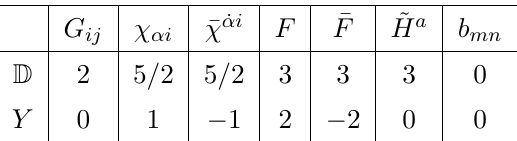
Table 2 . Summary of the dilatation and chiral weights in the off-shell linear